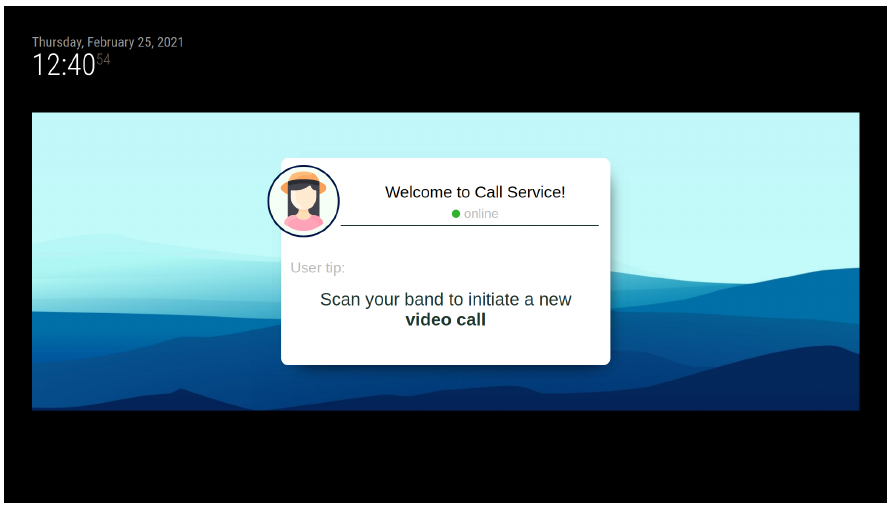
Figure 6. The call service interface.